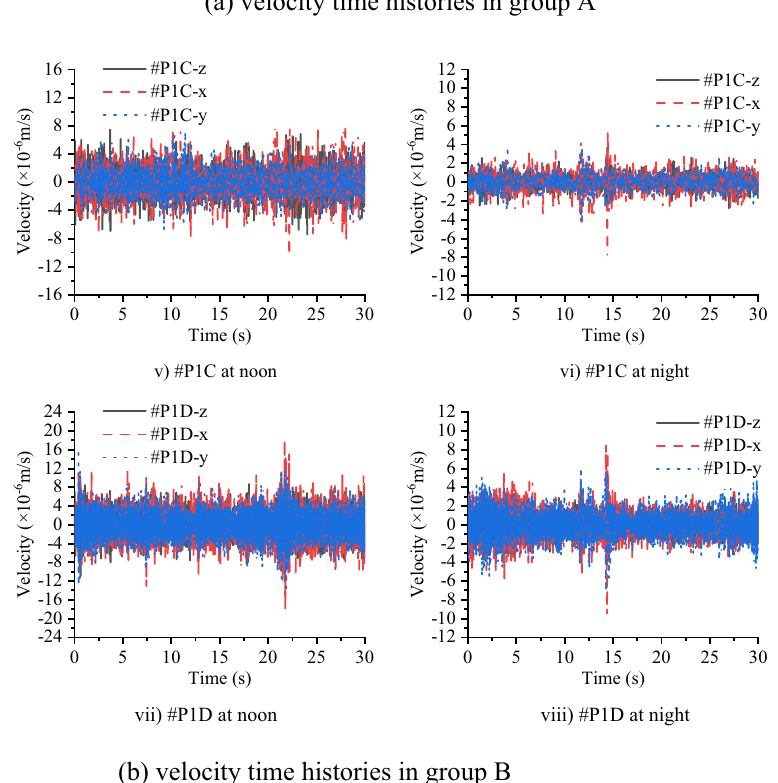
Figure 9. Velocity time histories in group A and group